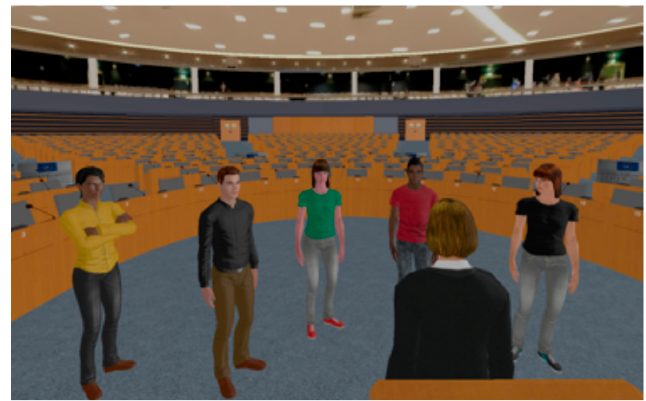
Figure 6. Proximity of users with the ECA.